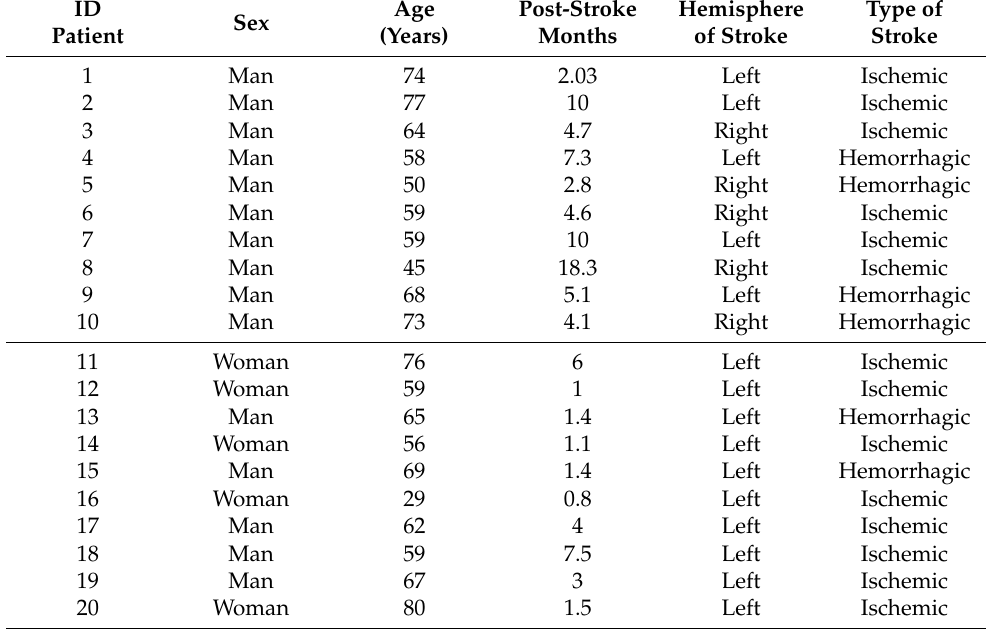
Table 1. Demographic data. 1–10: VR + CP; 11–20: